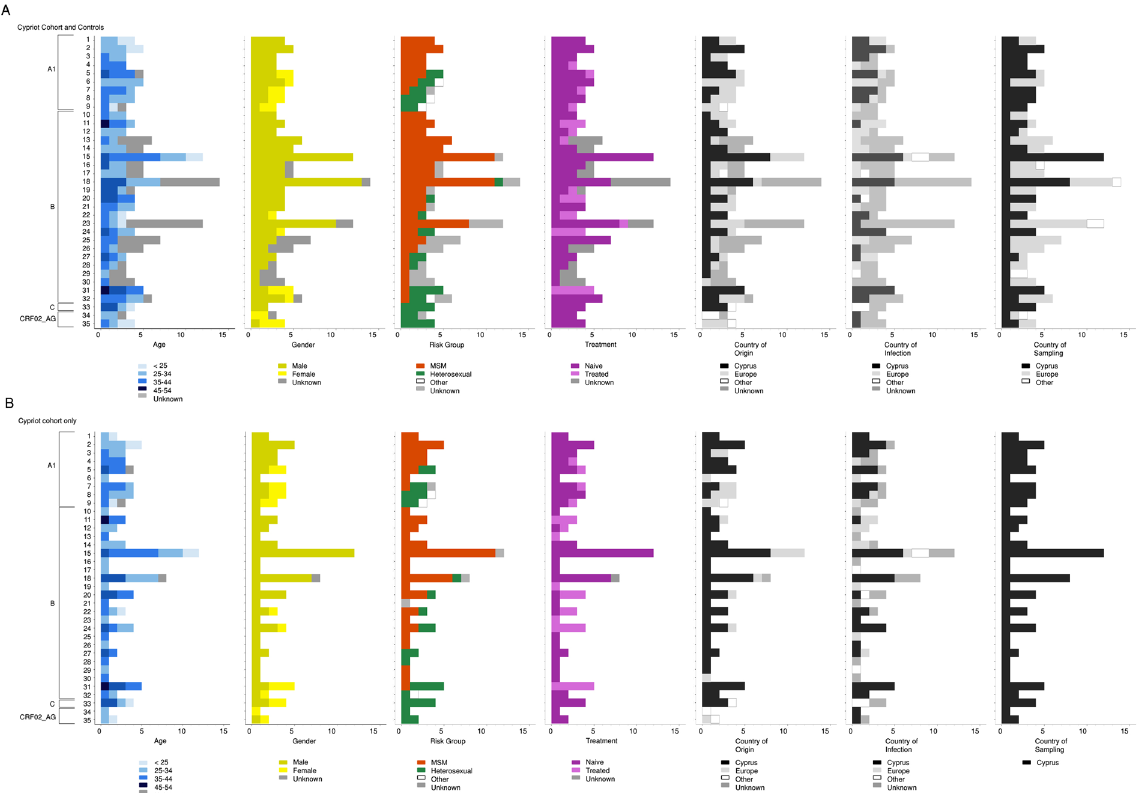
Figure 4. Epidemiological and demographic information of transmission clusters. For each TC, epidemiological (age, gender, risk group and treatment) and demographic (country of origin, country of infection and country of sampling) are illustrated. (A) Cypriot cohort and controls and (B) Cypriot cohort